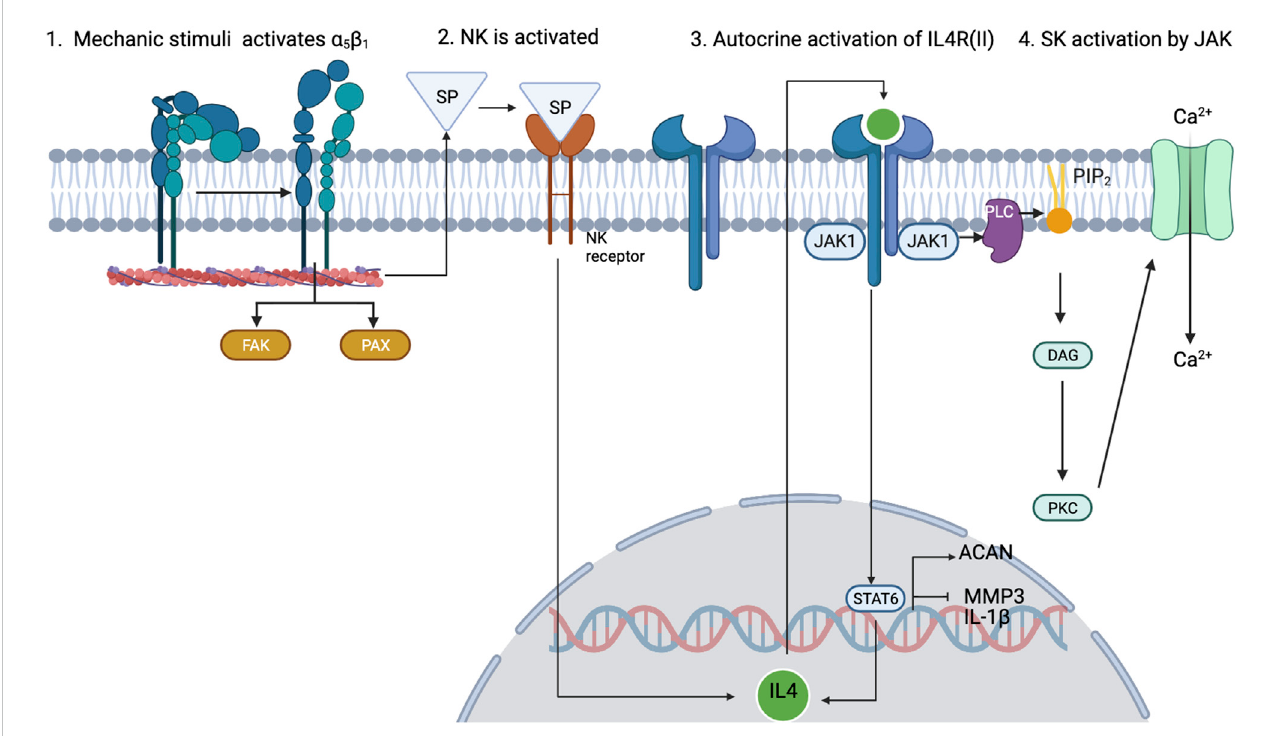
FIGURE 3 Schematicviewofhow0.33-Hzcyclicalstraininducestheactivationof α 5 β 1integrinandleadstotheexpressionofIL-4throughthereleaseofsubstance P (SP). Adapted from Millward-Sadler et al. (1999); Statham et al. (2021). Created with BioRender.com